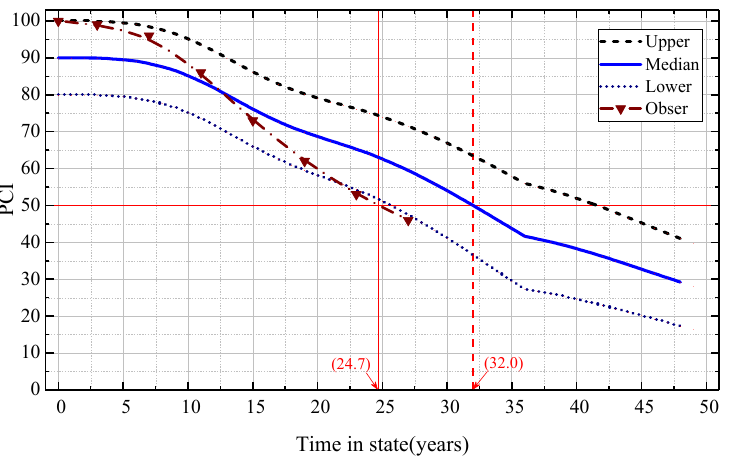
Figure 5. PCI prediction of the Markov model for airport pavement sample Data1S08.